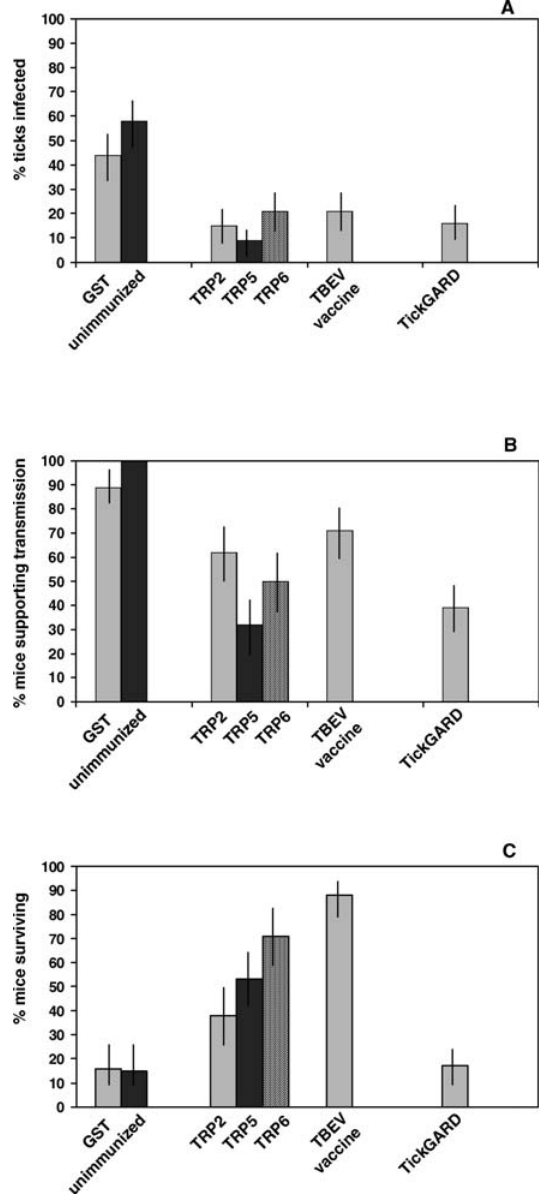
Figure 1. Effect of Immunization on Mice Infested with Virus-Infected and -Uninfected